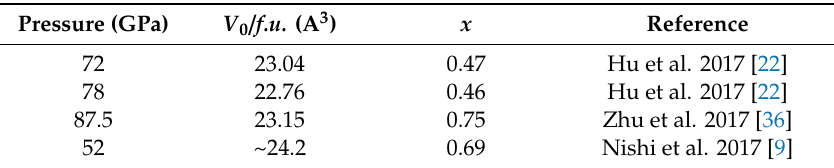
Figure 4. A schematic figure showing partially dehydrogenated ε -FeOOH x . The ε -FeOOH x phase inherits the hydrogen loss from pyrite-type FeO 2 H x . Table 3. Hydrogen content x in ε -FeOOH x .